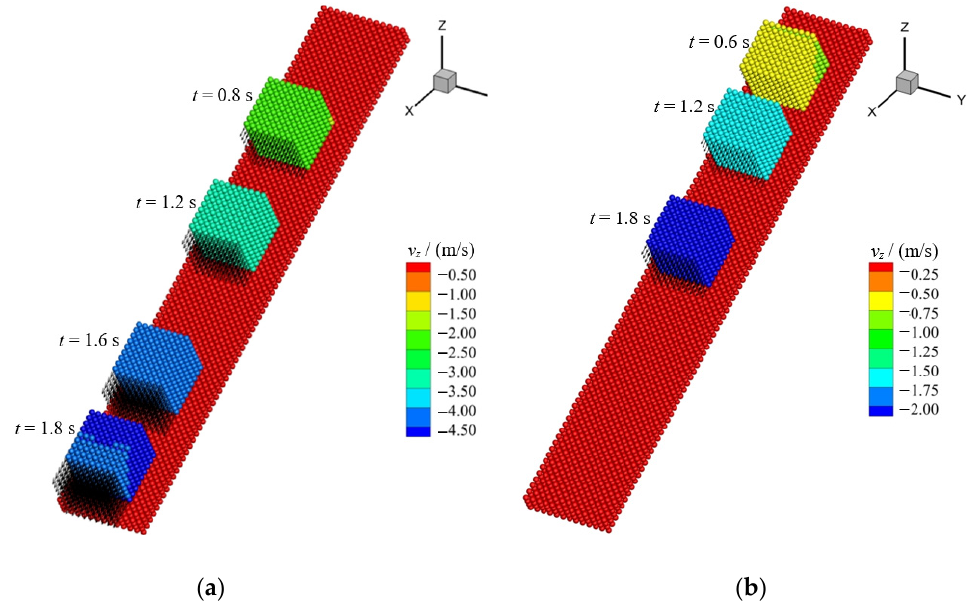
Figure 7. Calculation results of the particle-to-particle contact algorithm: ( a ) Friction coefficient µ = 0; ( b ) Friction coefficient µ = 0.3.